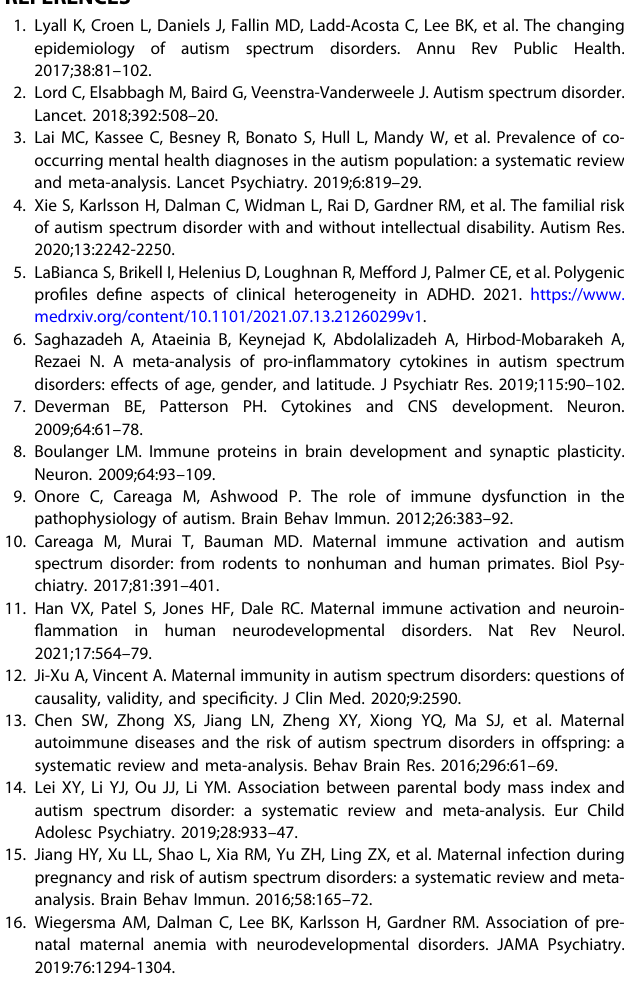
Fig. 5 The relationship between maternal APP and odds of ASD with co-occurring ADHD when comparing mothers of 117 individuals affected by ASD with co-occurring ADHD to mothers of 429 unaffected individuals selected from the cohort. Each panel displays the odds of ASD with co-occurring ADHD according to APP z-score, fl exibly fi t using restricted cubic spline models with three knots and a z-score = 0 as the referent. The dashed line represents the unadjusted estimate of the relationship between each APP and odds of ASD with co-occurring ADHD. The solid line represents the fully adjusted model, adjusted for sex, birth order, maternal BMI, maternal psychiatric history, maternal region of origin, maternal age and family income quintile. The gray bands represent the 95% con fi dence interval for the fully adjusted model. P values are shown for a Wald test with a null hypothesis that all APP spline terms were jointly equal to zero, as a test of whether each APP was generally associated with the outcome. Abbreviations: A2M α -2 macroglobulin, CRP C-reactive protein, FER ferritin, FIB fi brinogen, PCT procalcitonin, SAA serum amyloid A, SAP serum amyloid P, tPA tissue plasminogen